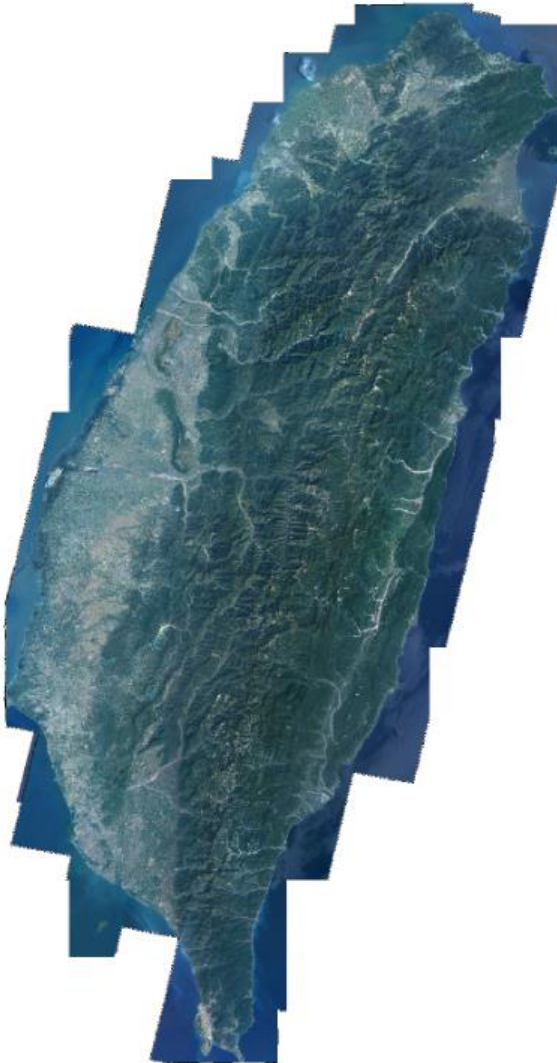
Figure 3. FORMOSAT-2 satellite image of Taiwan.